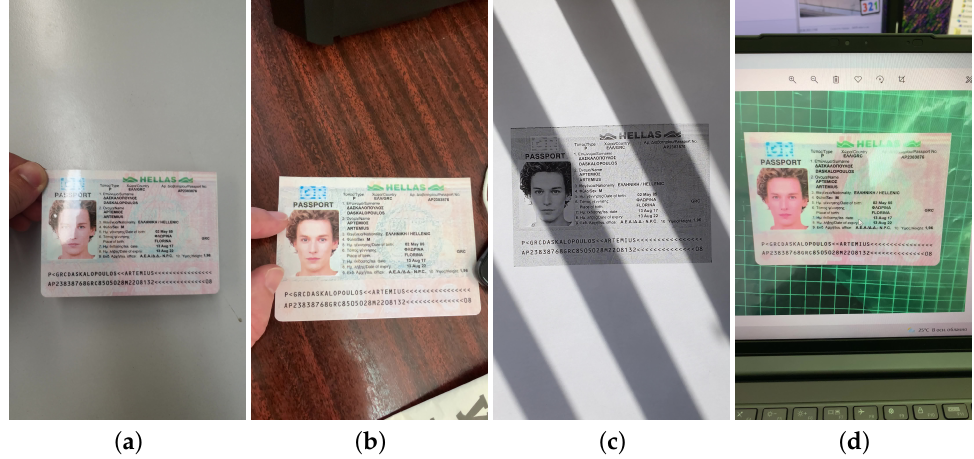
Figure 1. Types of video in DLC-2021 dataset: ( a ) original document, ( b ) unlaminated color copy, ( c ) unlaminated gray copy, and ( d ) document recaptured from